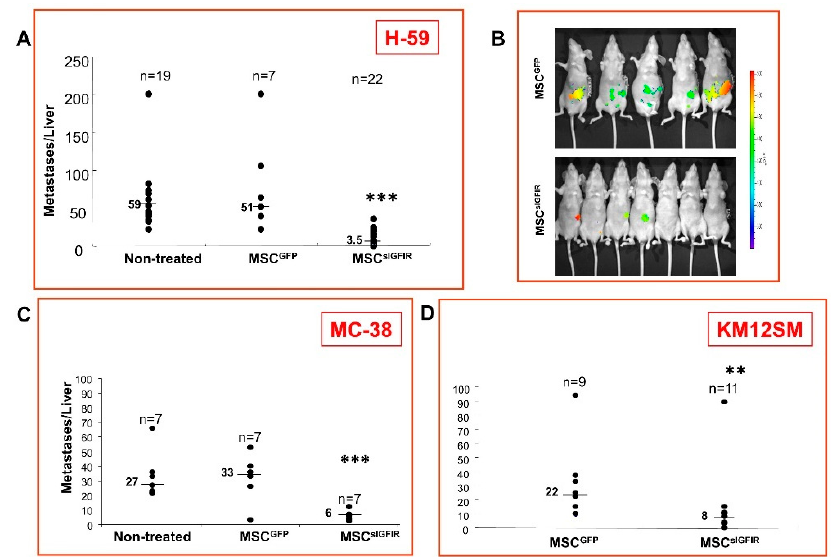
Figure 2. Bone marrow stromal cells producing a soluble IGF-IR inhibit experimental hepatic metastasis of lung and colon carcinoma. Syngeneic female C57Bl / 6 ( A and C ) or nude ( B and D ) mice were implanted with 10 7 genetically engineered marrow-derived stromal cells (MSCs) expressing sIGFIR (MSC sIGFIR ) or control MSC (MSC GFP ) embedded in Matrigel. Fourteen days later ( A – D ), the mice were inoculated via the intrasplenic / portal route with 10 5 H-59 ( A and B ), 5 × 10 4 murine colon carcinoma MC-38 ( C ) or 10 6 human colon carcinoma KM12SM ( D ) cells. Mice were euthanized and liver metastases enumerated 14–16 ( A ), 18 ( C ) or 21 ( D ) days after or imaged using the IVIS 100 Xenogen 15 days ( B ) post tumor inoculation. Shown in ( A ) are the pooled data of three and in ( B – D ) individual experiments. Results of optical imaging are shown in ( B ). ** p < 0.01, *** p < 0.001, as determined by the non-parametric Mann–Whitney test. Reproduced from